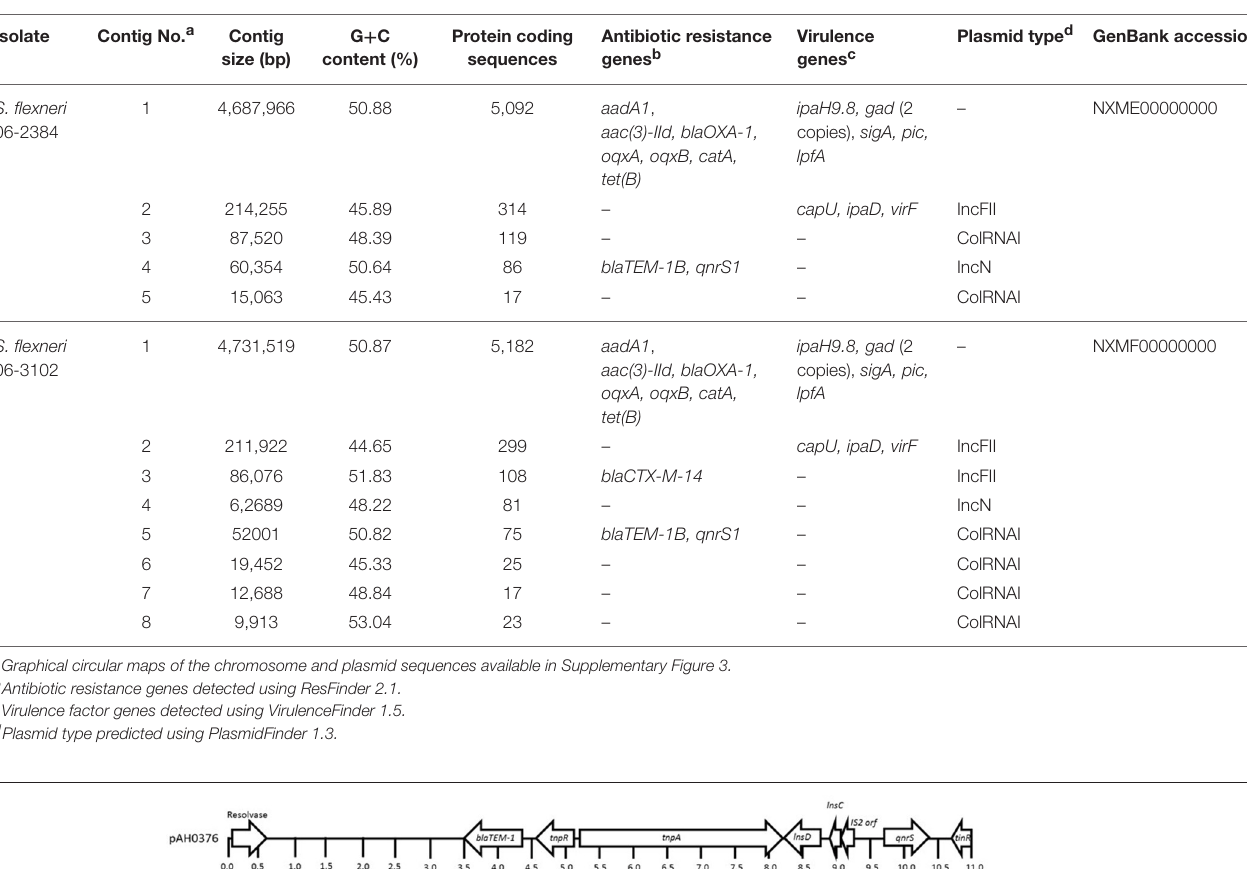
TABLE 2 | Genomic characteristics of representative Shigella flexneri isolates. Isolate